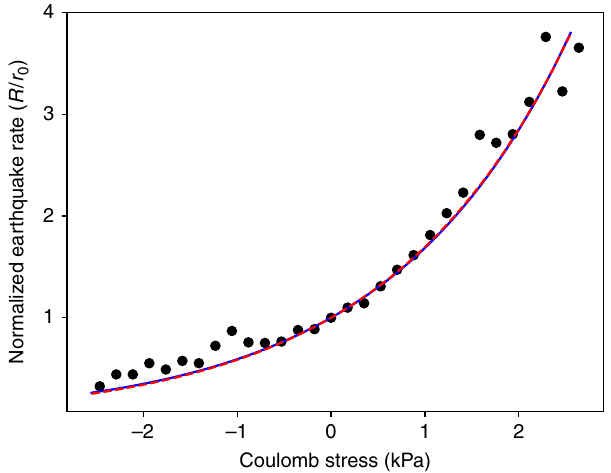
Fig. 5 Normalized seismicity rate change vs. change in Coulomb stress. Coulomb stress is converted from tidal vertical stress using χ = 0.176 (from the state indicated by the plus sign in Fig. 4). Blue curve is the rate-state friction version and the red curve is the stress corrosion